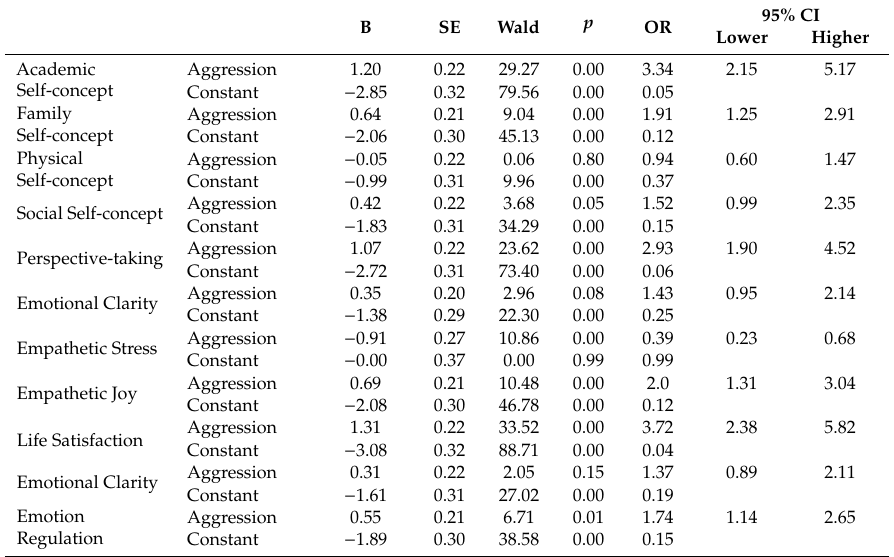
Table 1. Logistic regression with traditional aggression as a predictor of low scores.